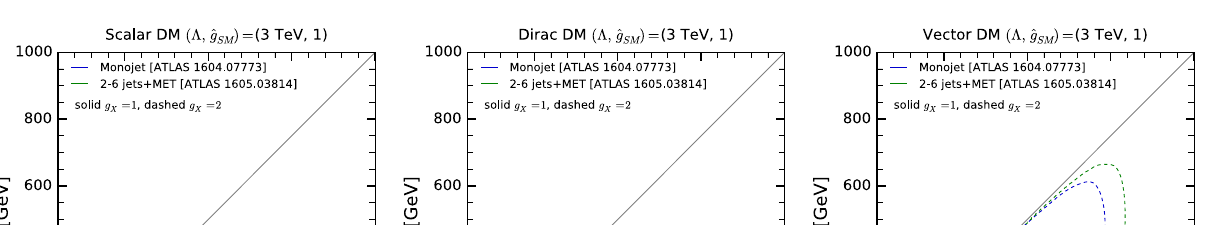
Fig. 7 Same as Fig. 5, but for the leptophobic scenario